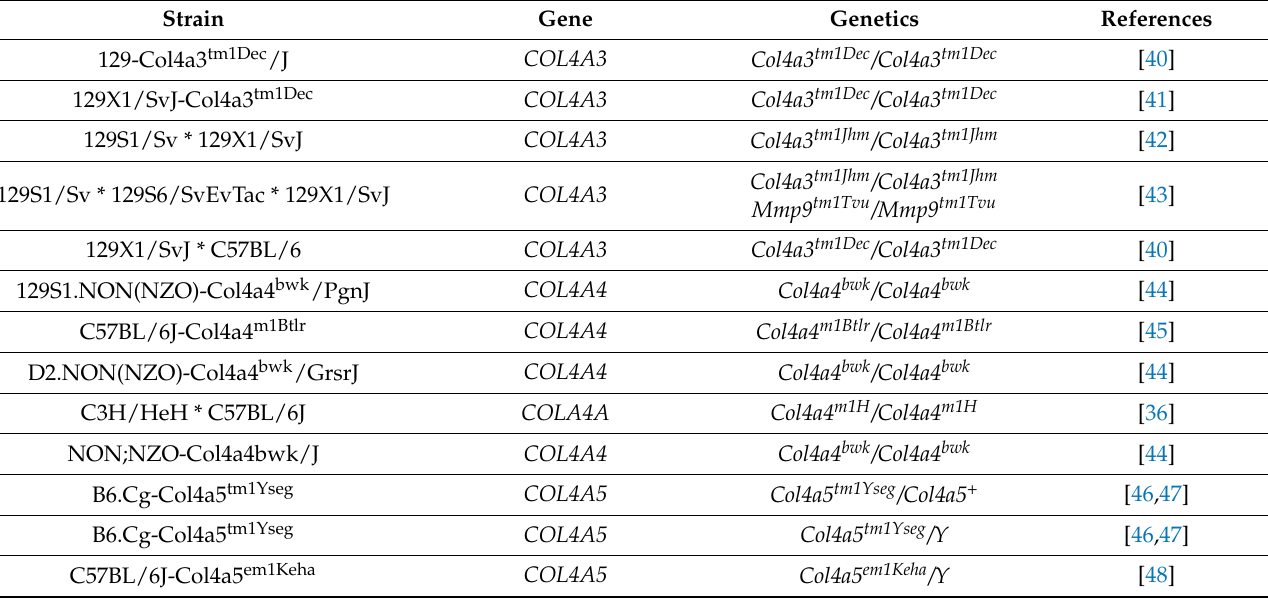
Table 1. Murine animal models of human Alport